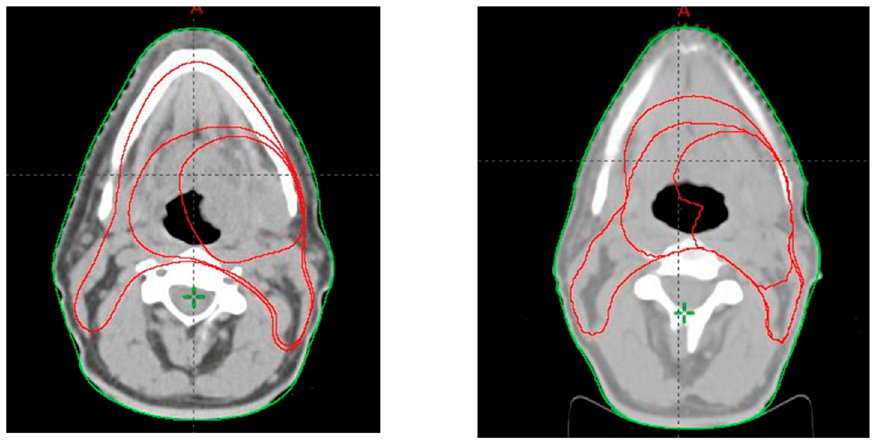
Figure 2. Tumor volumes contoured at first CT scan ( left ) and second CT scan after completion of 18 radiotherapy fractions ( right ).